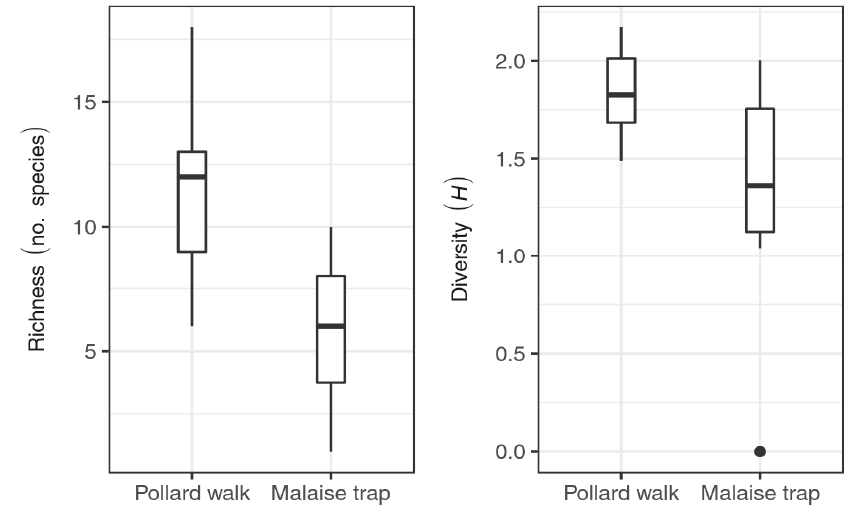
Figure 3. Species richness and diversity (Shannon’s H ) observed across 16 BioSCAN Malaise traps and 16 ButterflySCAN Pollard walk sites between 15 March 2015 and 15 July 2015. Central lines are median values, boxes bound the first and third quartiles, and whiskers indicate 1.5 times the interquartile range (IQR).